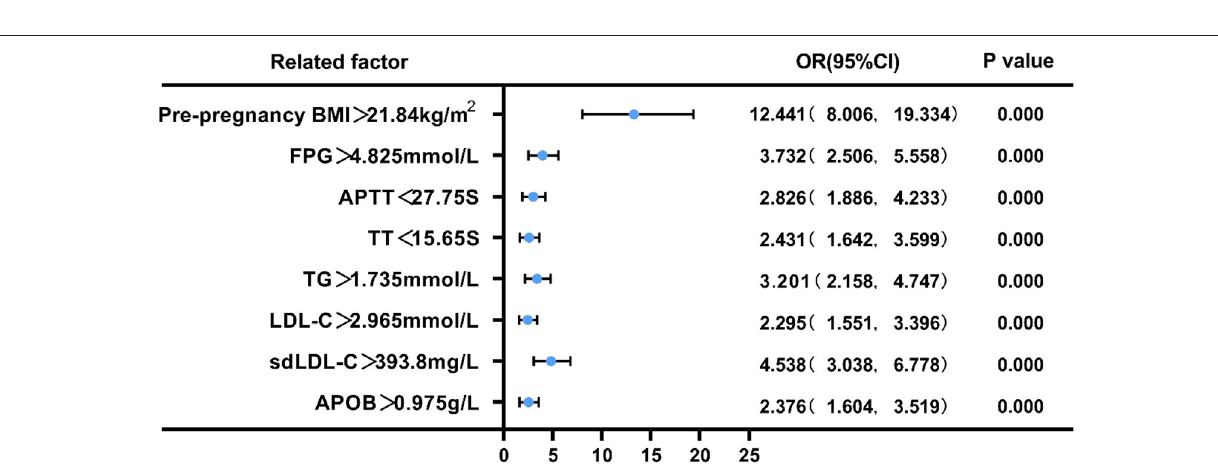
Frontiers in Public Health |